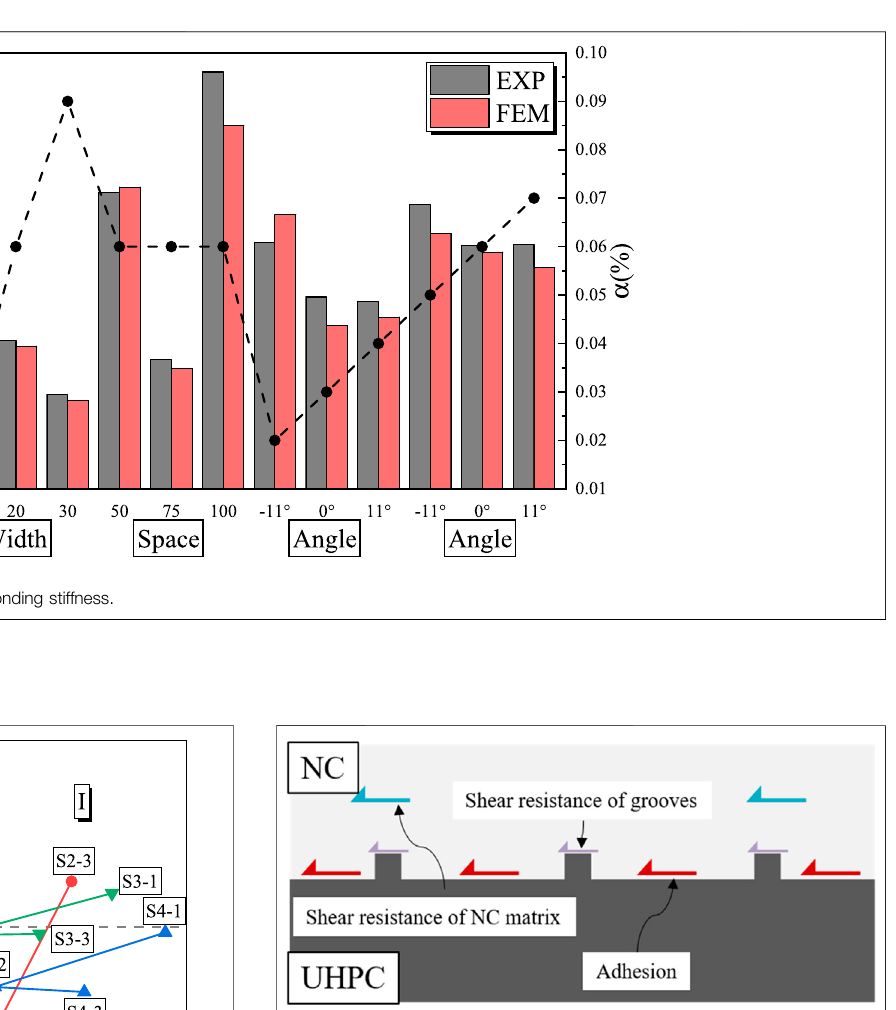
FIGURE 11 | Shear resistance mechanisms of UHPC – NC interfaces with grooves.